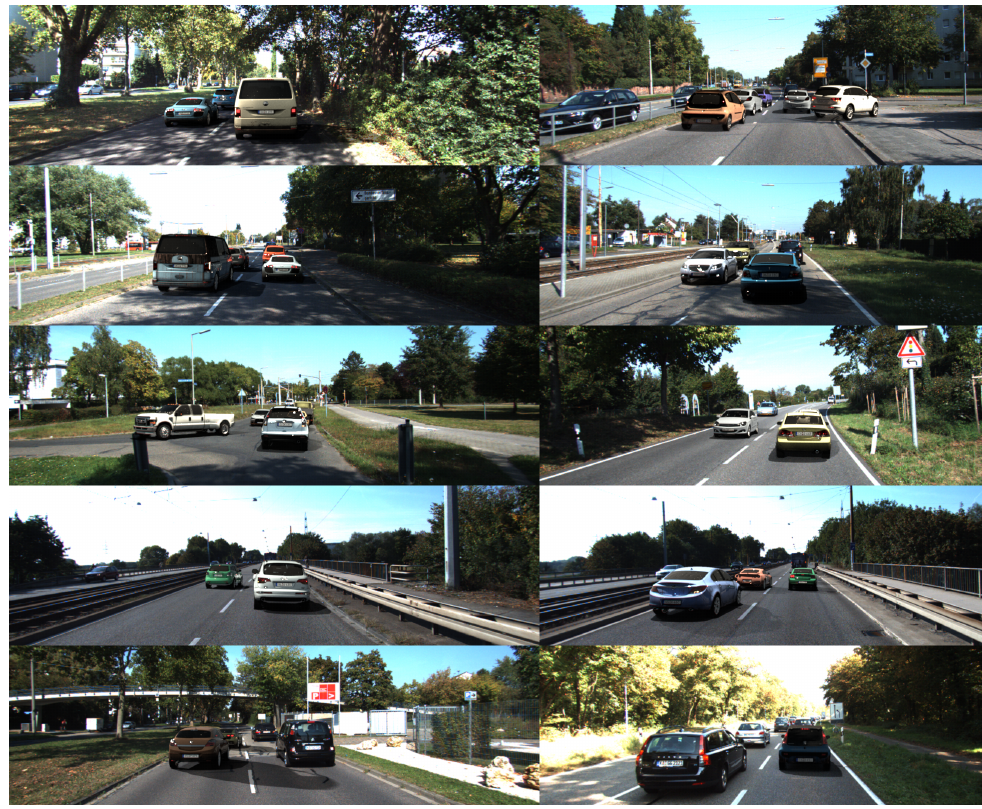
Figure 8. Some examples of augmented cars for KITTI dataset. All sub-images have equal meaning. They depict cars, some of which are synthetic and some are